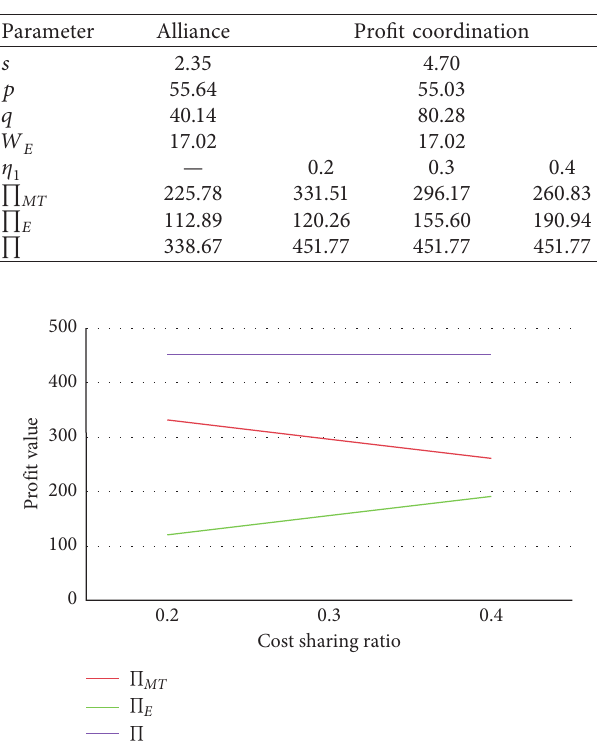
Figure 1: Sensitivity of revenue sharing in semicentralized model 1. Table 6: Coordination results of cost sharing in semicentralized model 1.